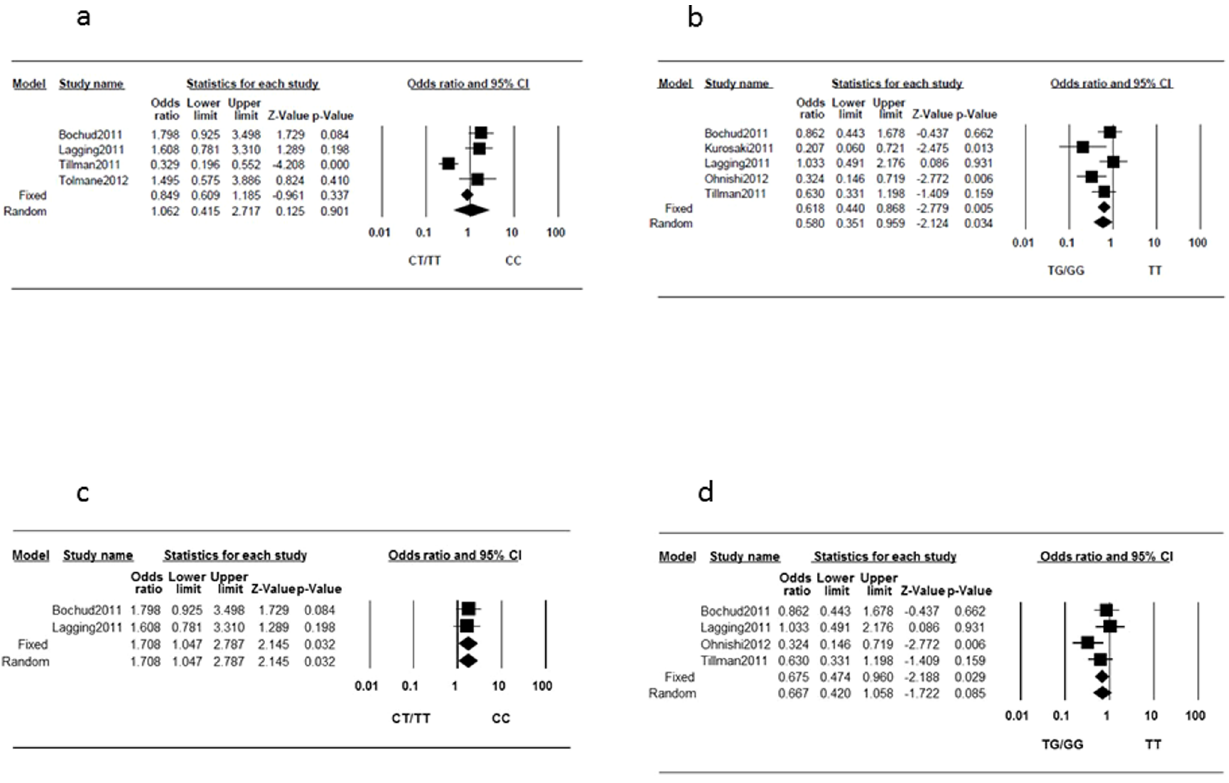
Figure 4. Forest plot of the IL28B genotypes and the risk of hepatic steatosis. (a) rs12979860 and (b) rs8099917. (c) rs12979860 in treatment-naı¨ve patients, and (d) rs8099917 in treatment-naı¨ve patients.